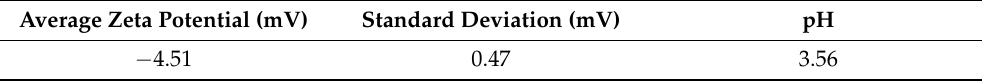
Table 4. Zeta potential measurements results.